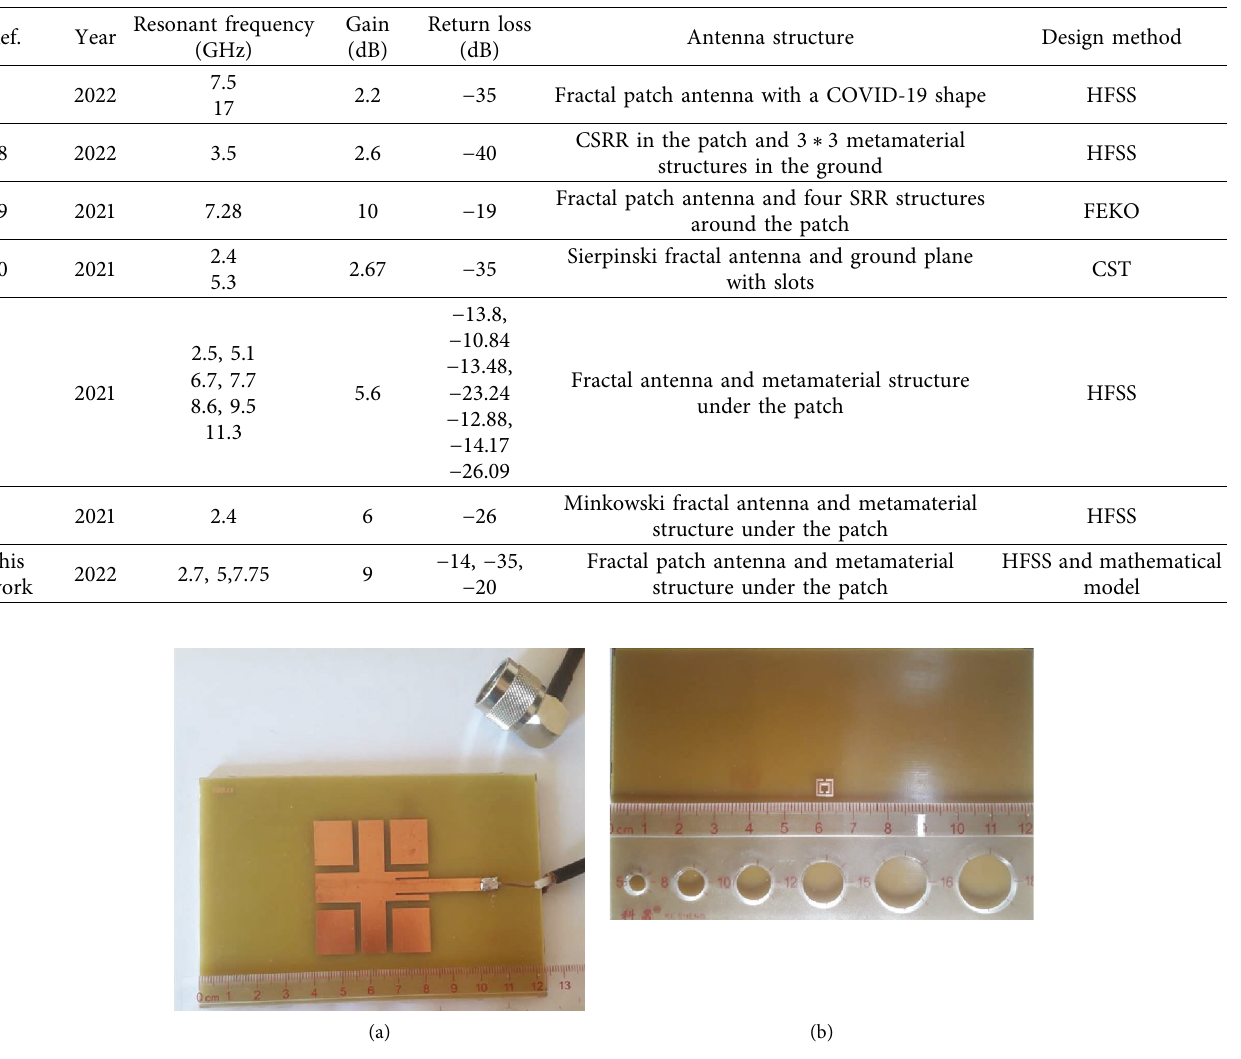
Figure 15: Fabricated proposed antenna. (a) Fractal antenna. (b) Metamaterial structure.